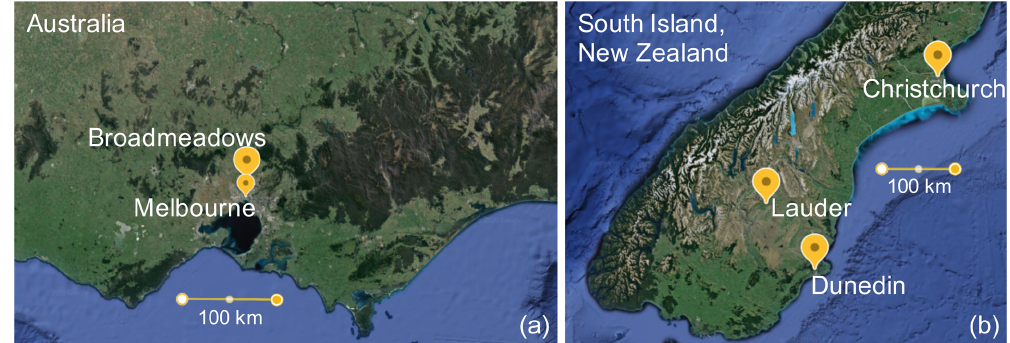
Figure 1. Maps of (a) south-eastern Australia showing the location of Melbourne and the Broadmeadows measurement site, and (b) the South Island of New Zealand showing the locations of Lauder and the largest South Island cities, Dunedin and Christchurch. Map generated in Google